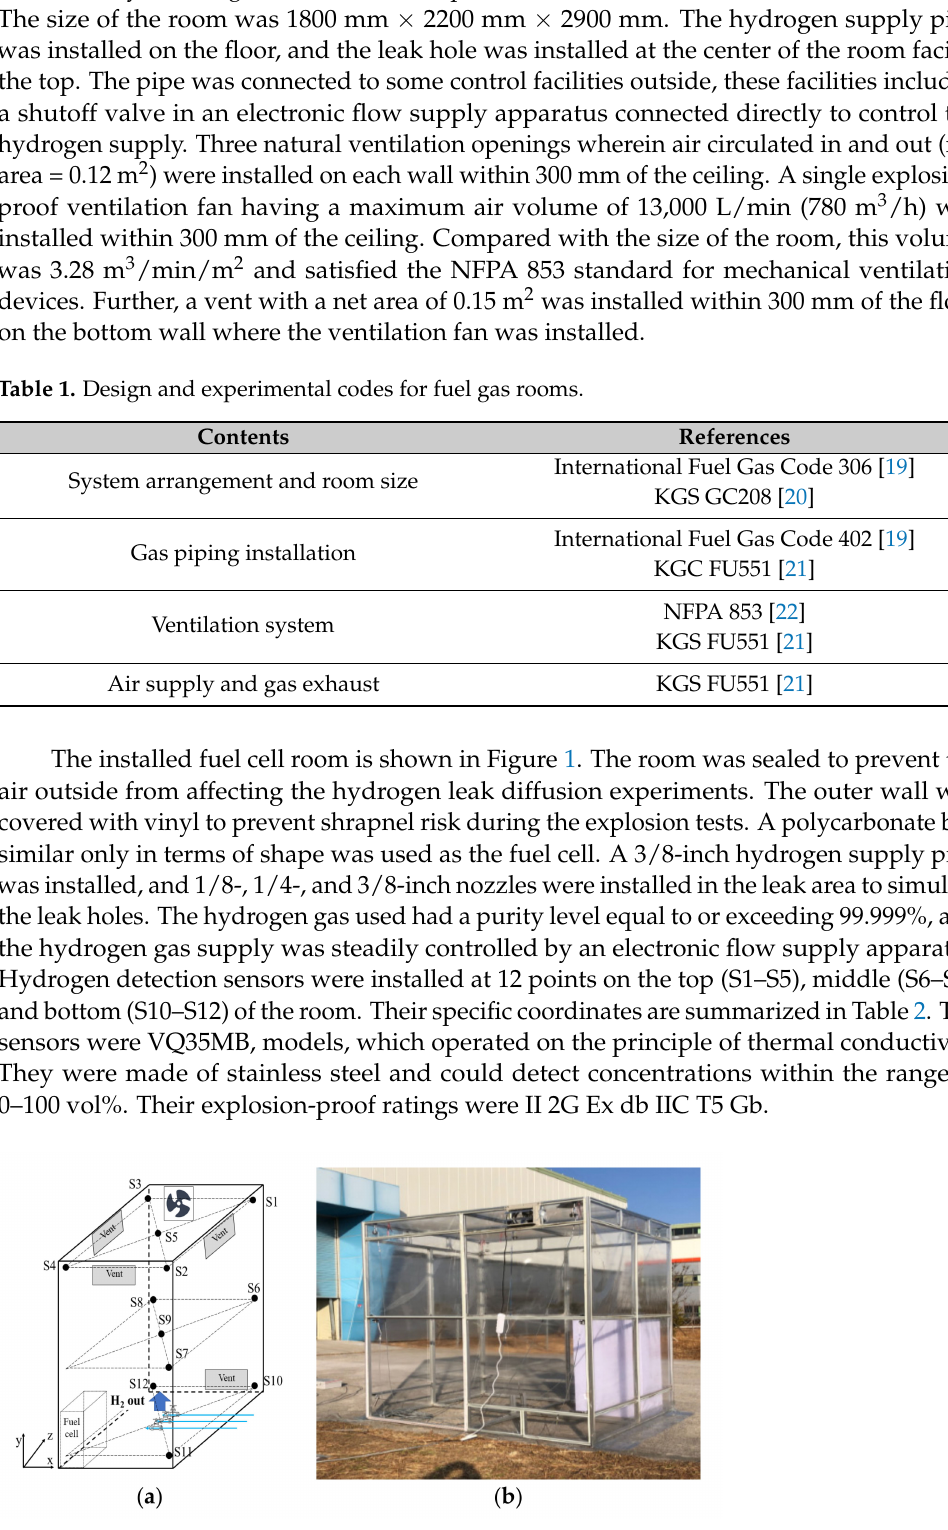
Figure 1. ( a ) Design and ( b ) equipment of fuel cell room for experiments. S1–S12 represent hydrogen concentration